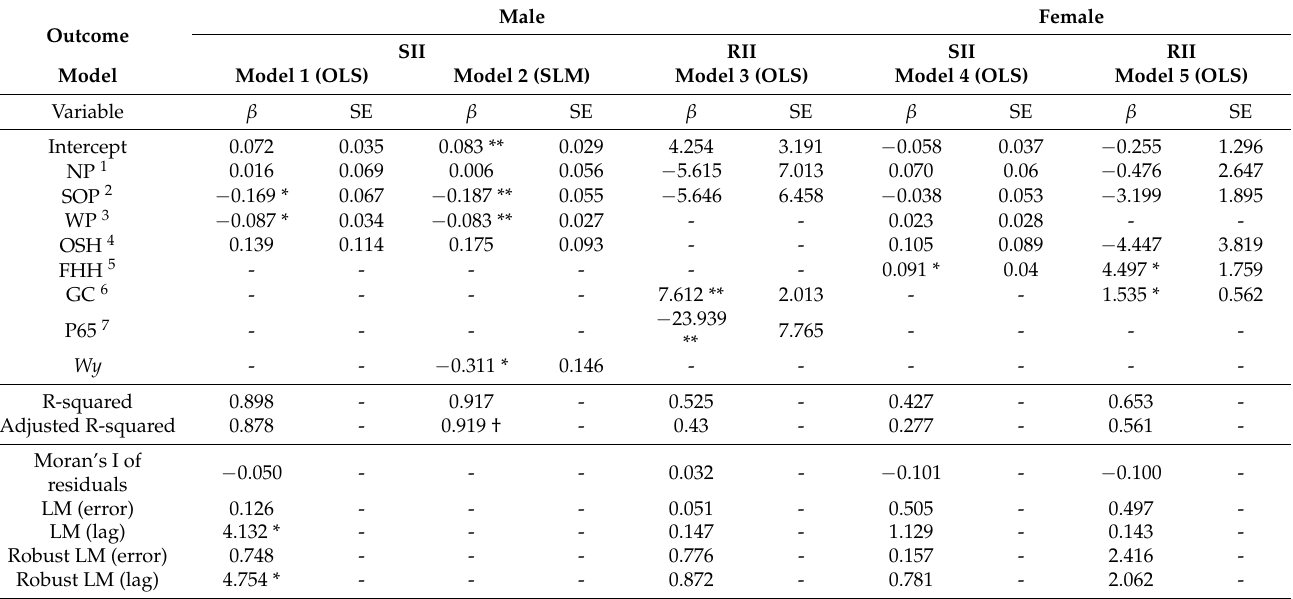
Table 5. OLS and spatial regressions for SII and RII on demographic factors and socio-economic factors across 25 districts in Seoul for men and